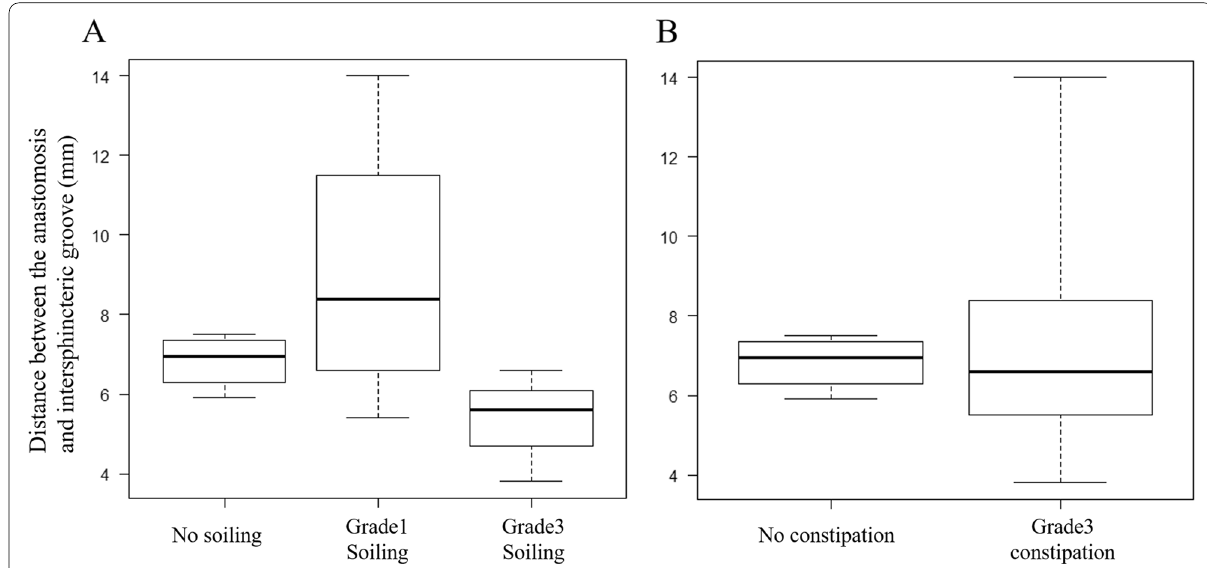
Fig. 2 The relationship between the distance from intersphincteric groove to the anastomosis and anal function. A Soiling and B constipation. The distance between the anastomosis and the intersphincteric groove is shorter in patients with grade 3 soiling than in the other groups. No relationship was found regarding